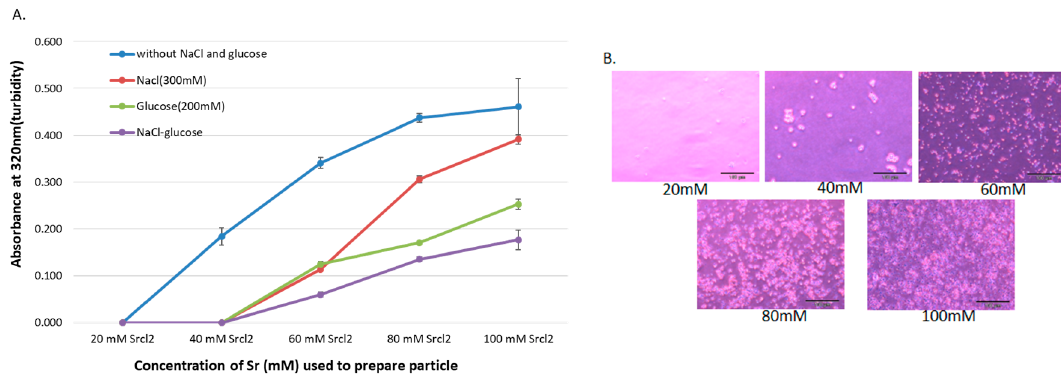
Figure 1. ( A ). Turbidity and optical microscopic analysis of differently formulated NPs. Turbidity (absorbance at 320 nm) of the particles formed without and with NaCl and/or glucose. Particles were formed by addition of 1–5 µ L of (1 M) SrCl 2 to 0.5 µ L of (1 M) Na 2 SO 3 in 50 µ L aqueous solution with or without inclusion of 25 µ L of NaCl (0.5 M) and/or 10 µ L of D -glucose (1 M), and incubation for 30 min at 37 ◦ C. Subsequently, serum-supplemented DMEM media was added to achieve 1 mL particle suspension. Absorbance at 320 nm wavelength was measured for all generated NPs using a spectrophotometer. ( B ). Microscopic observation of Na-Glc-SSNs prepared at different Sr 2+ concentrations, and images were captured at 10× resolution.